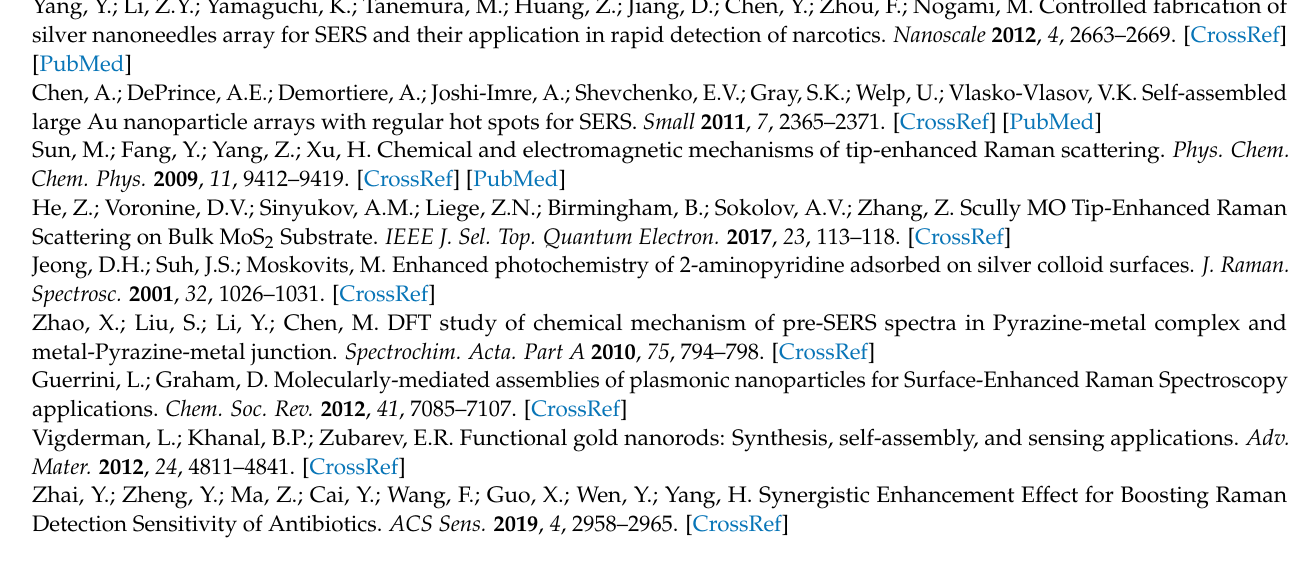
of ZnO, Co 400 -ZnO, and Co 400 -ZnO/Au. (A) Wide-angle patterns and (B) Selected-angle patterns; Figure S18: Size distribution of ZnO quantum dots in Co 400 -ZnO/Au; Figure S19: TEM-EDS result of Co-ZnO/Au; Figure S20: Concentration-dependent SERS spectra of R6G solutions recorded on Co 400 -ZnO; Figure S21: SERS spectra of R6G (10 − 7 ) recorded on Co 400 -ZnO/Au under different irradiations with 532, 633, and 785 nm lasers; Figure S22: (A) SERS spectra of R6G molecules adsorbed onto Co-ZnO/Au. (B) SERS spectra of Tyr (1 × 10 − 8 M) on Co-ZnO/Au, ZnO/Au, and Au NPs; Figure S23: Normal Raman spectrum of powder Tyramine; Figure S24: (A) SERS spectra of R6G (10 − 6 M) recorded from 20 randomly- selected points on Co 400 -ZnO/Au. (B) The statistic on Raman Intensities of R6 G (10 − 6 M) recorded from 20 randomly- selected points on Co 400 -ZnO/Au; Figure S25: Raman intensities of R6G (10 − 6 M) by using Co 400 -ZnO/Au monitored during storage in ambient condition for 90 days; Figure S26: The SERS spectra of R6G (10 − 6 M) recorded on the three batches of Co 400 -ZnO/Au substrate; Table S1: Summary of Crystallite size (D), Dislocation density ( ρ ), and Micro strain ( ε ); Table S2:. Binding energy (BE) of Co in Co-ZnO samples; Table S3: Binding energy (BE) of Zn and O in Cox-ZnO samples; Table S4: The band gap (Eg) and optical absorption edge (nm) of pure ZnO and Co-ZnO samples; Table S5: Binding energy (BE) of ZnO, Co 400 -ZnO and Co 400